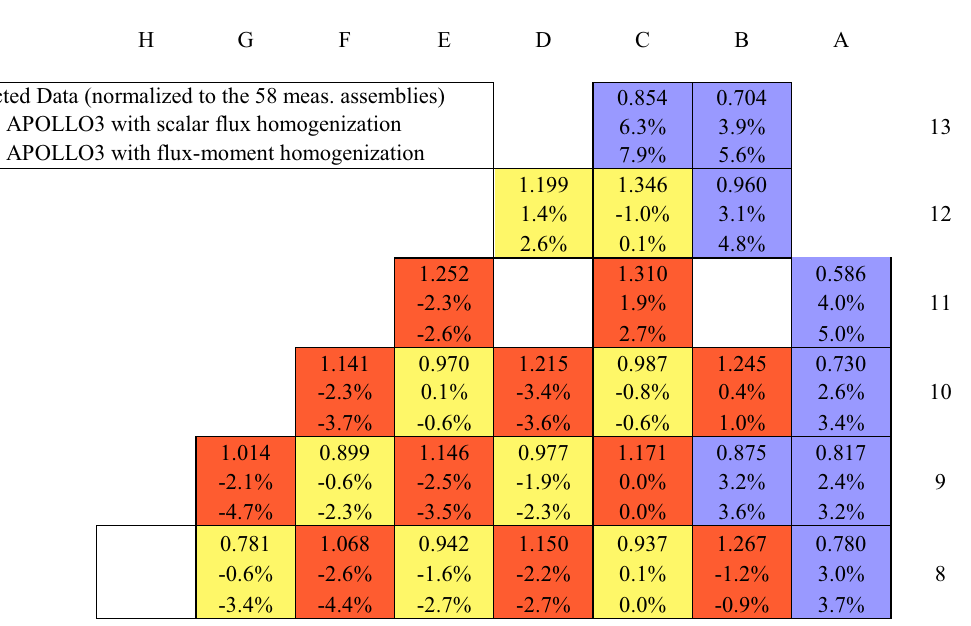
Figure 5. APOLLO3-MINARET differences with tilt-corrected measurement data (1/8 th core